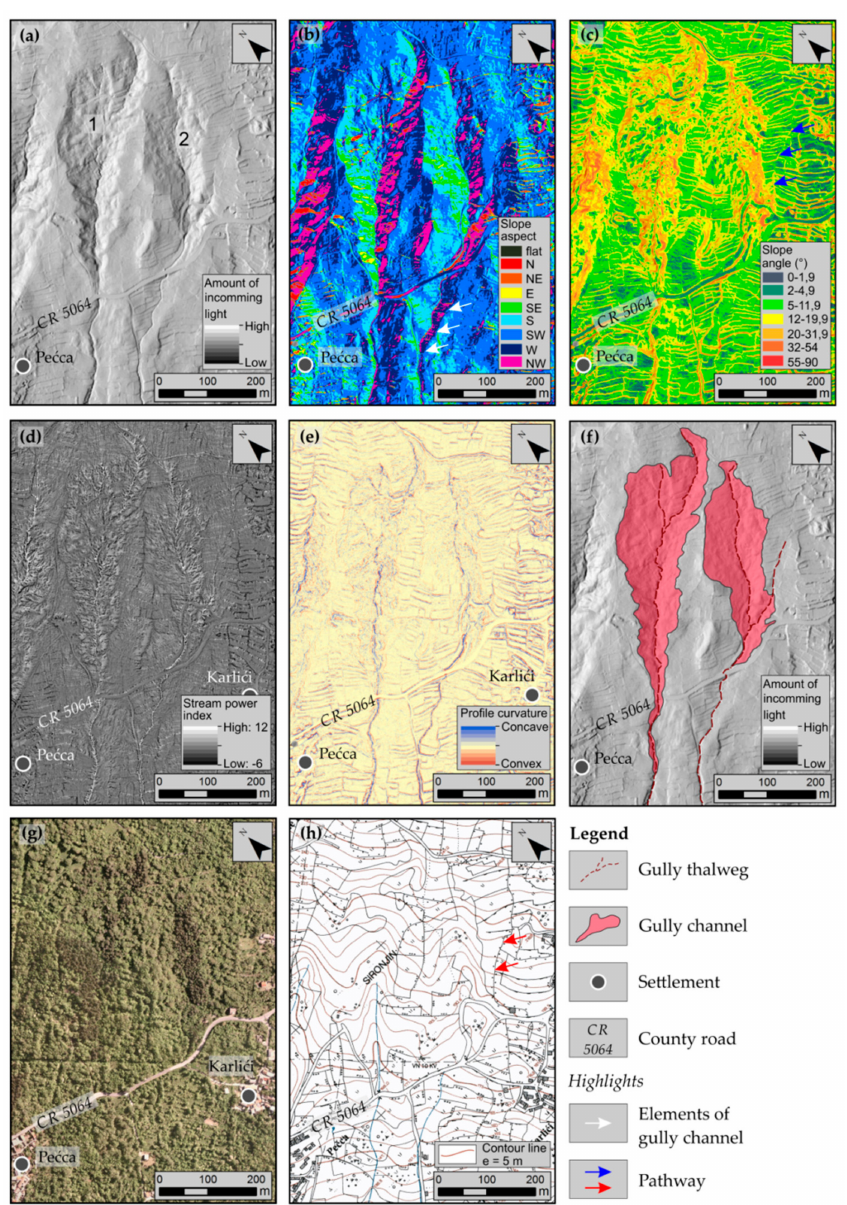
Figure 5. Visualization of topography of two linear gullies of well-preserved topography on high resolution (HR) light detection and ranging (LiDAR) imagery: ( a ) the hillshade map 315 ◦ / 45 ◦ ; ( b ) the aspect map; ( c ) the slope map; ( d ) the stream power index map; and ( e ) the profile curvature map. ( f ) The hillshade map with delineated polygons representing the gully channels and lines representing the gully thalwegs; ( g ) the DOM 1:5000; and ( h ) the CBM 1:5000 of the interpreted